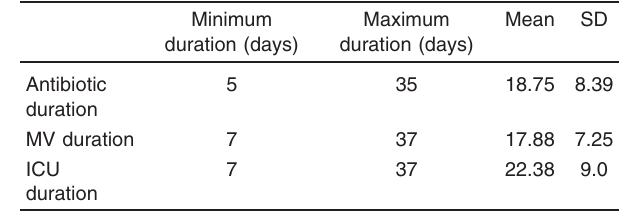
Tecoblanin, linozolid